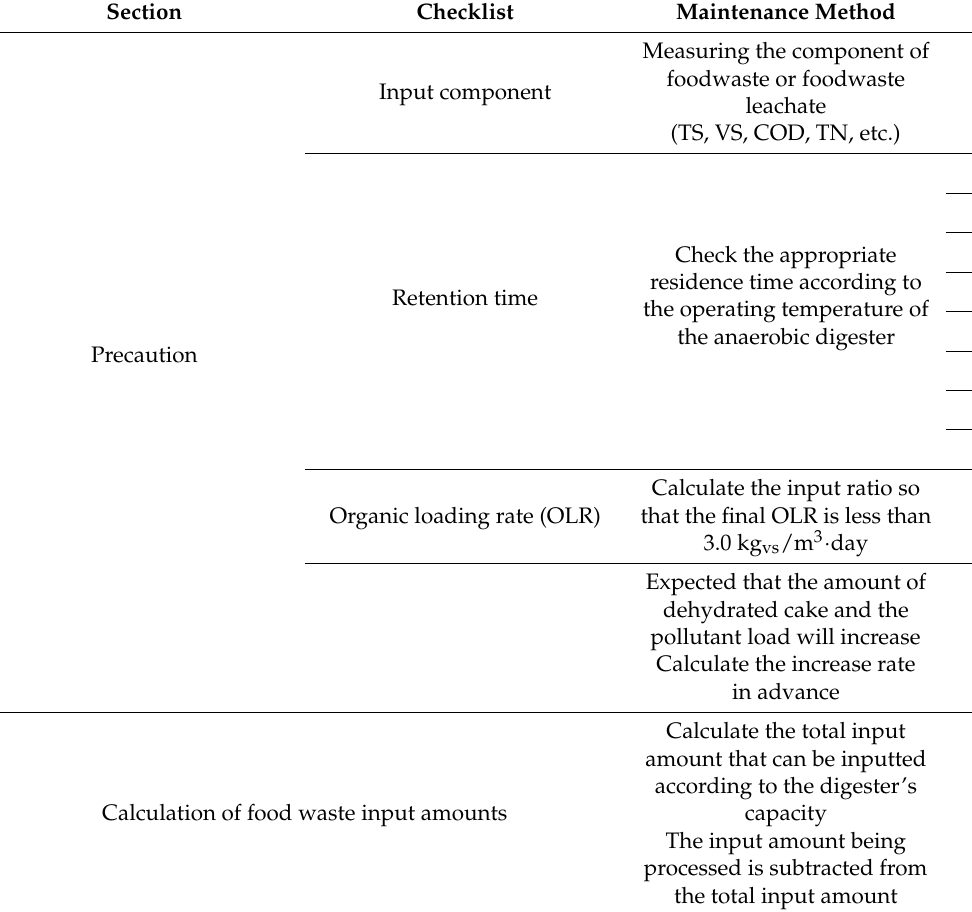
Table 9. Checklist and maintenance methods for emergency food waste treatment in the sewage treatment